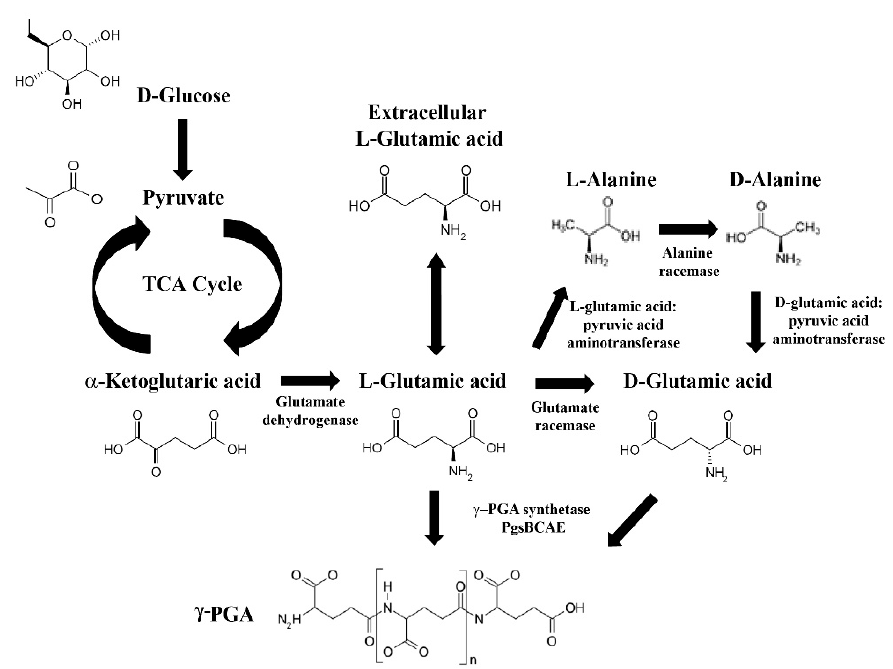
Figure 1. Routes of poly- γ -glutamic acid ( γ -PGA) synthesis. Arrows: demonstrate the proceeding directions of the reaction. Bi-directional arrows reflect the chemical reaction is reversible. Arced arrows: represent the reaction cycle.